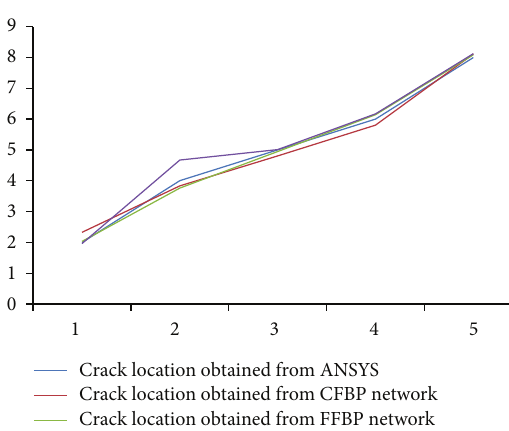
Relative crack depth obtained from ANSYS Relative crack depth obtained from CFBP network Relative crack depth obtained from FFBP network Relative crack depth obtained from RBF network Figure 18: Overall comparison of result of relative crack depth among ANSYS, CFBP, FFBP, and RBF networks.